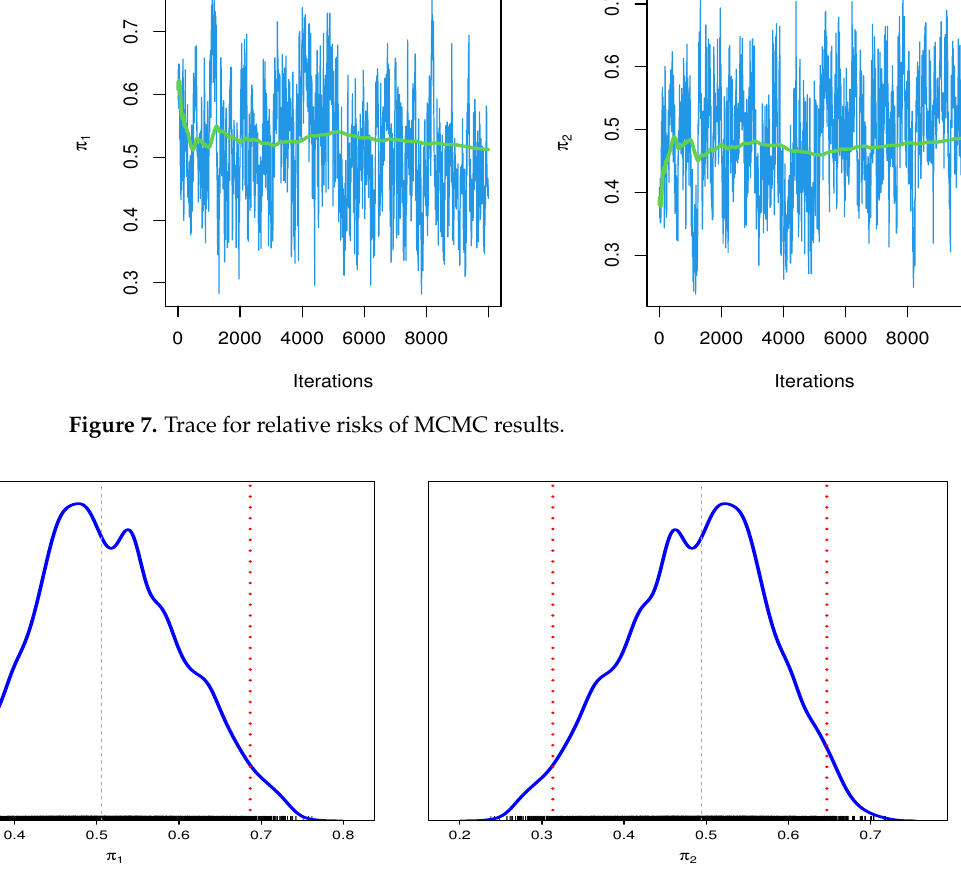
Figure 8. The posterior density for relative risks of MCMC